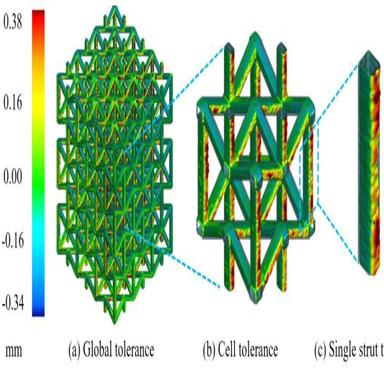
Comparison between 3D CT reconstruction model and CAD model.